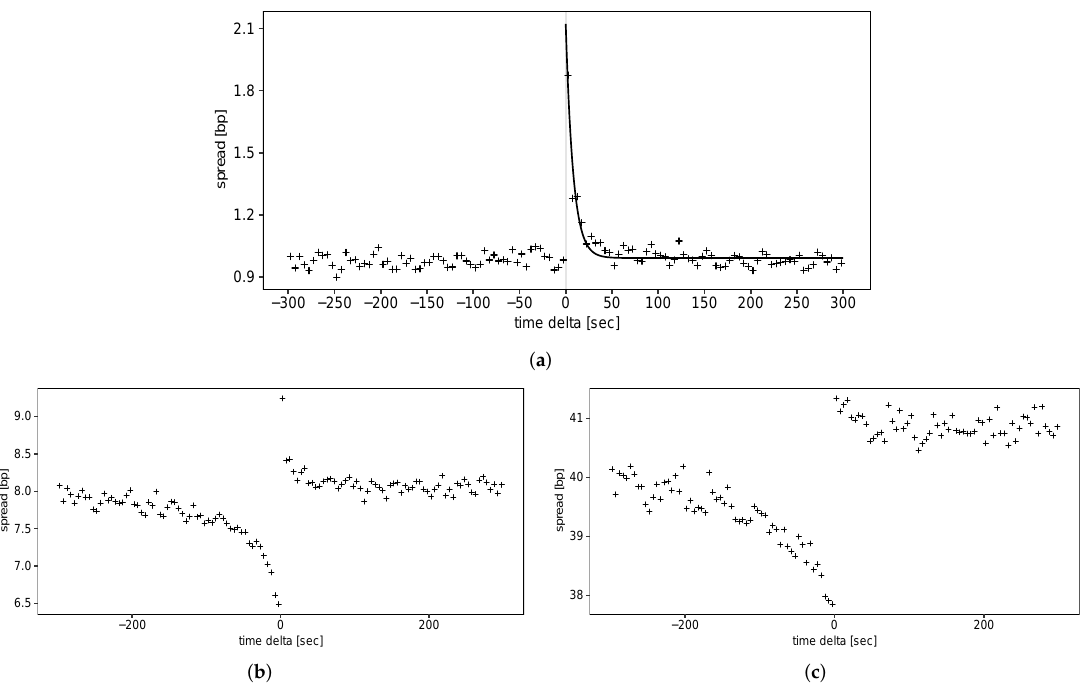
Figure 8. Resiliency of liquidity costs. The figures display three different average measures of liquidity cost in the event time τ of the 1 percent largest trades. ( a ) Evolution of the average bid-ask spread ¯ s ( τ ) . We fit an exponential function with time constant 8.3s to guide the eye.; ( b ) Evolution of the average volume-weighted average price spread ¯ vs ( ω , τ ) for a volume of ω = 10 5 USD; ( c ) Evolution of the average volume-weighted average price spread ¯ vs ( ω , τ ) for a volume of ω = 10 6